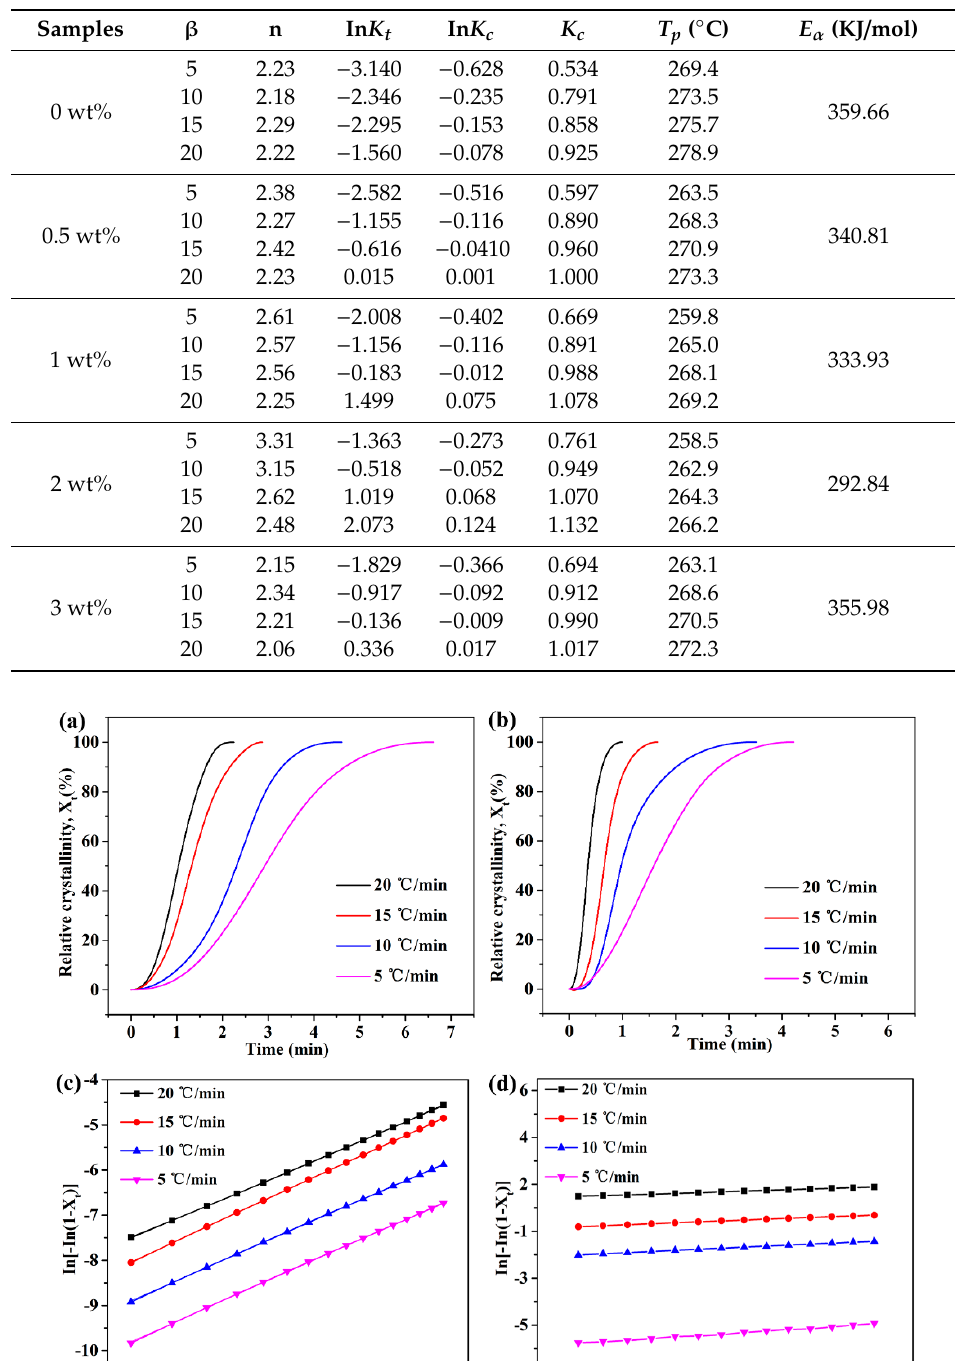
Table 1. Detailed data of non-isothermal crystallization kinetic parameters of various